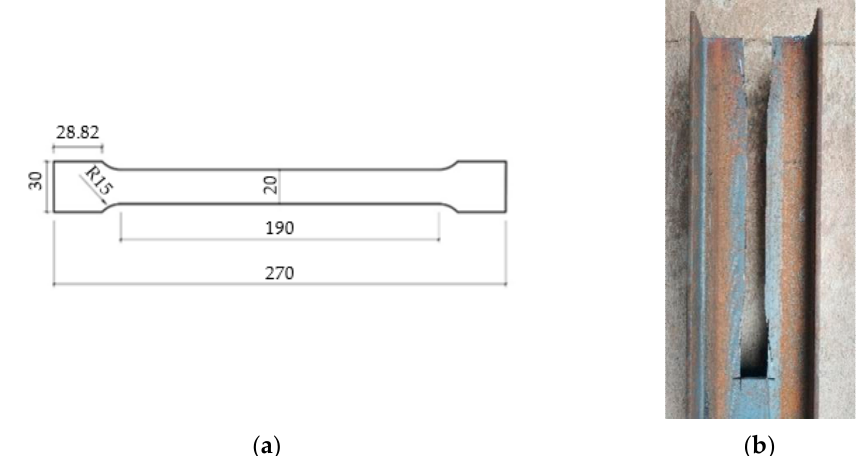
Figure 4. Processing of the tensile specimens: ( a ) Processing size; ( b ) Sampling location.